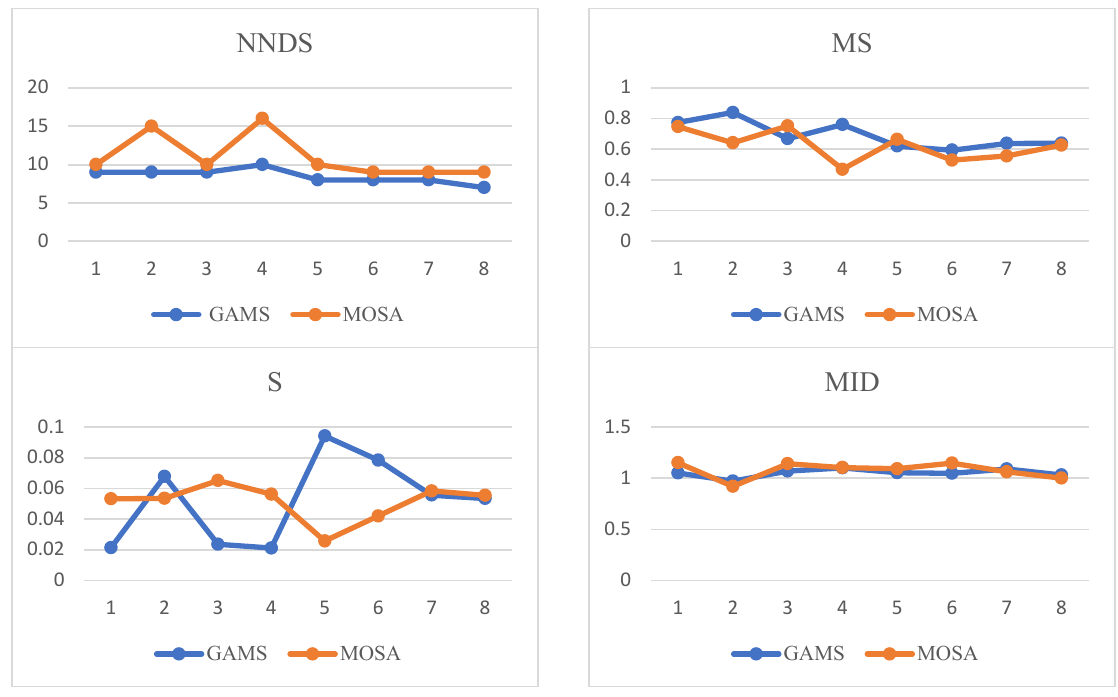
Fig. 9. comparison of solving methods